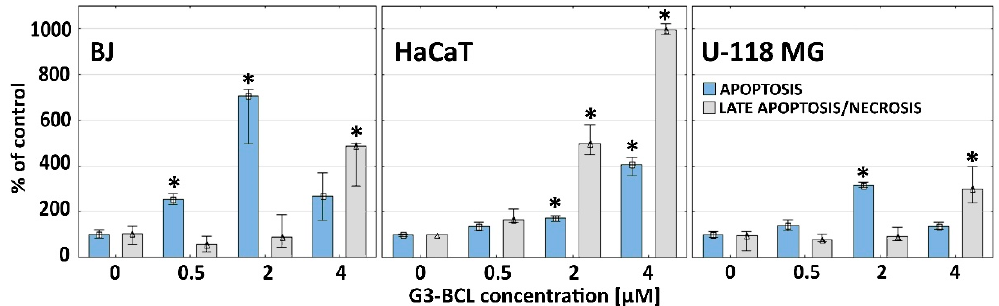
Figure 6. Caspase 3 / 7 activity and late apoptotic / necrotic cell population in BJ, HaCaT, and U-118 MG cells after 24 h treatment with G3-BCL conjugate. Results are medians of triplicate from three independent experiments expressed as % of the non-treated controls. The whiskers are lower (25%) and upper (75%) quartile ranges. * P < 0.05 (Kruskal–Wallis test).